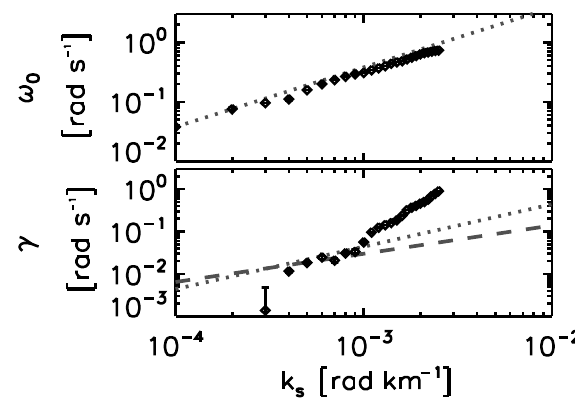
Figure 6. Peak frequency ω 0 (upper panel) as a function of the streamwise wavenumbers with comparison to the Doppler shift (dotted line) and half-value width γ (lower panel) with compari- son to the random sweeping (dotted line) and eddy turnover time (dashed